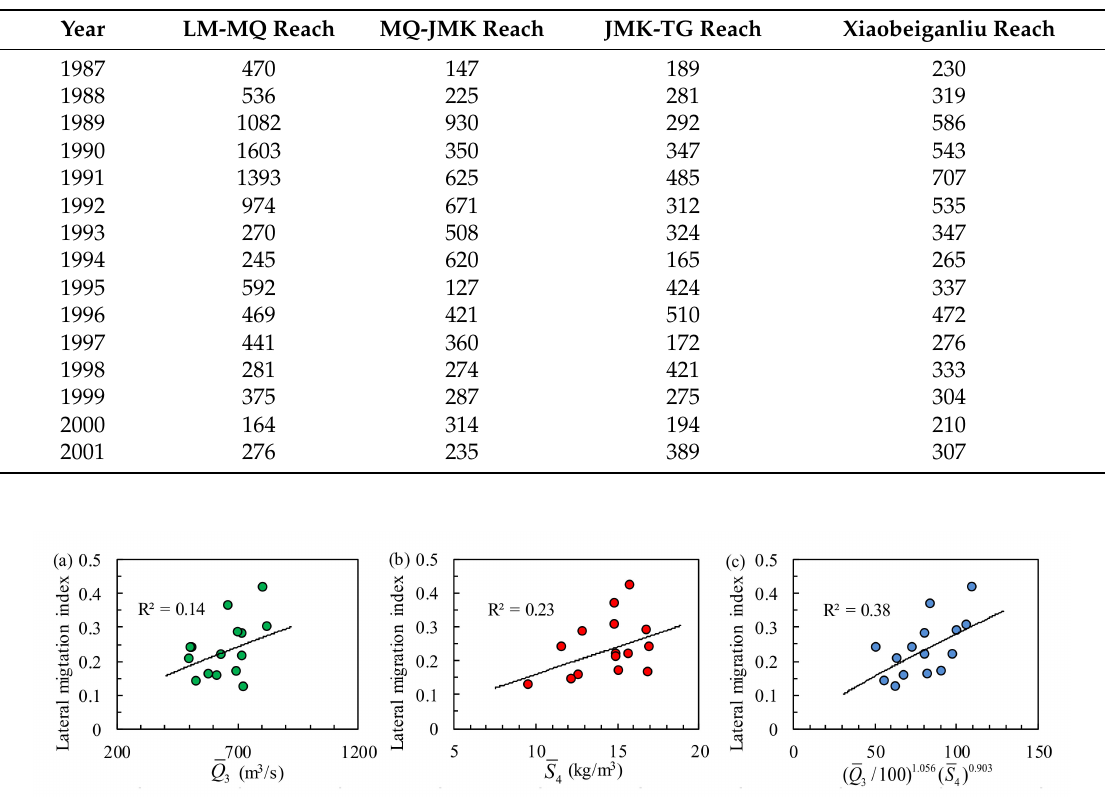
Figure 7. Relationships between the lateral migration index and the upstream boundary conditions in the Xiaobeiganliu reach: ( a ) previous 3–year average water discharge; ( b ) previous 4-year sediment concentration; ( c ) comprehensive